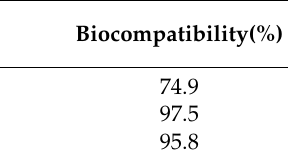
Table 1. Three alternative CPAs and five